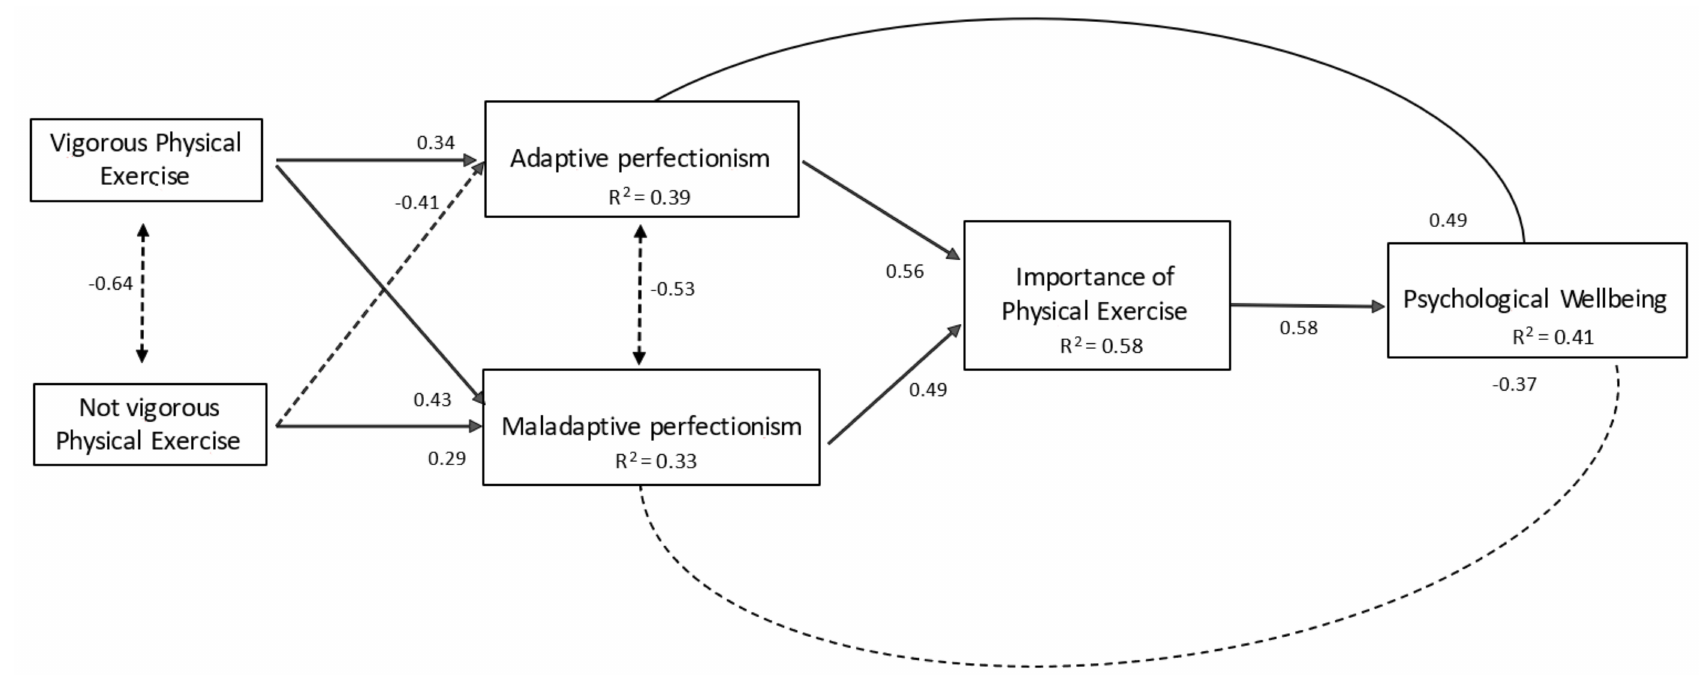
Figure 2. Hypothesized model regarding the practice of physical exercise, perfectionist patterns, and psychological well-being in